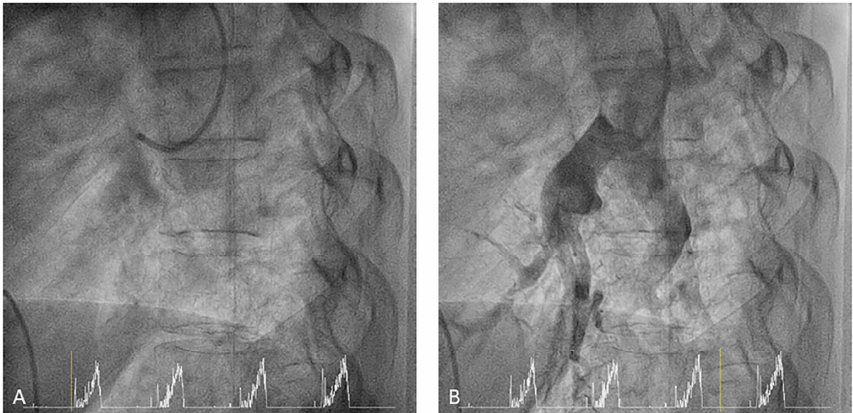
Figure 25. JR catheter position canulating the left lower lobe antero-lateral trunk (A8/9). Lateral Figure 23. MP catheter positions in the anteroposterior ( A ) (upper row) and lateral views ( B ) (lower Figure 26. JR catheter position canulating the left lower lobe antero-lateral trunk (A8/9). Lateral view view ( A ) without and ( B ) with contrast. row) to cannulate the ( D , E ) apical (A1) and ( C , F ) posterior (A2) left upper lobe branches. ( A ) without and ( B ) with contrast.